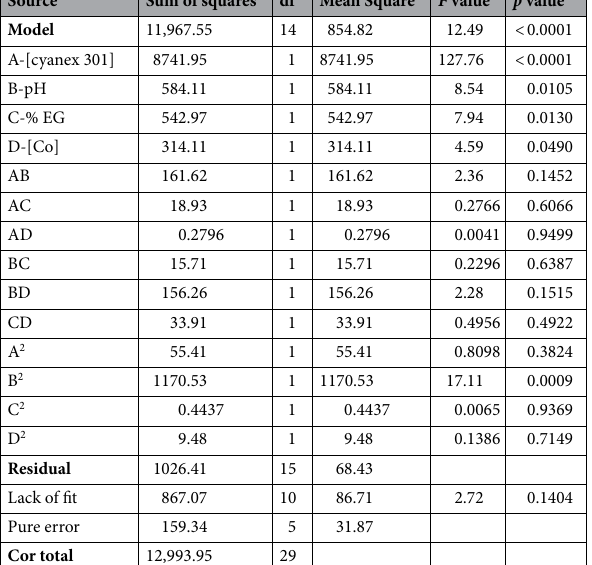
Table 3. Analysis of variance (ANOVA)